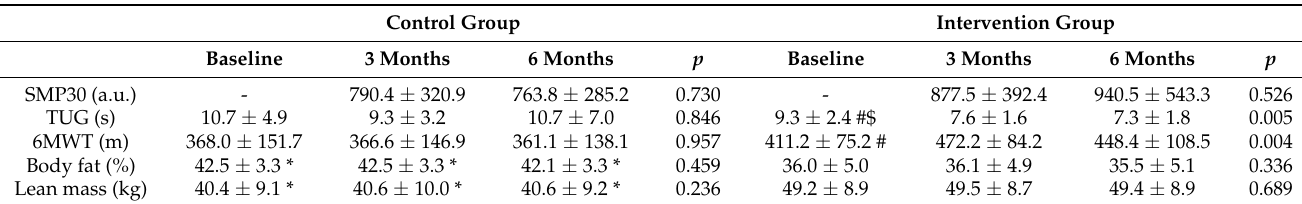
Table 2. SMP30, walking ability, and body composition in elders assigned to control or multicompo- nent training program